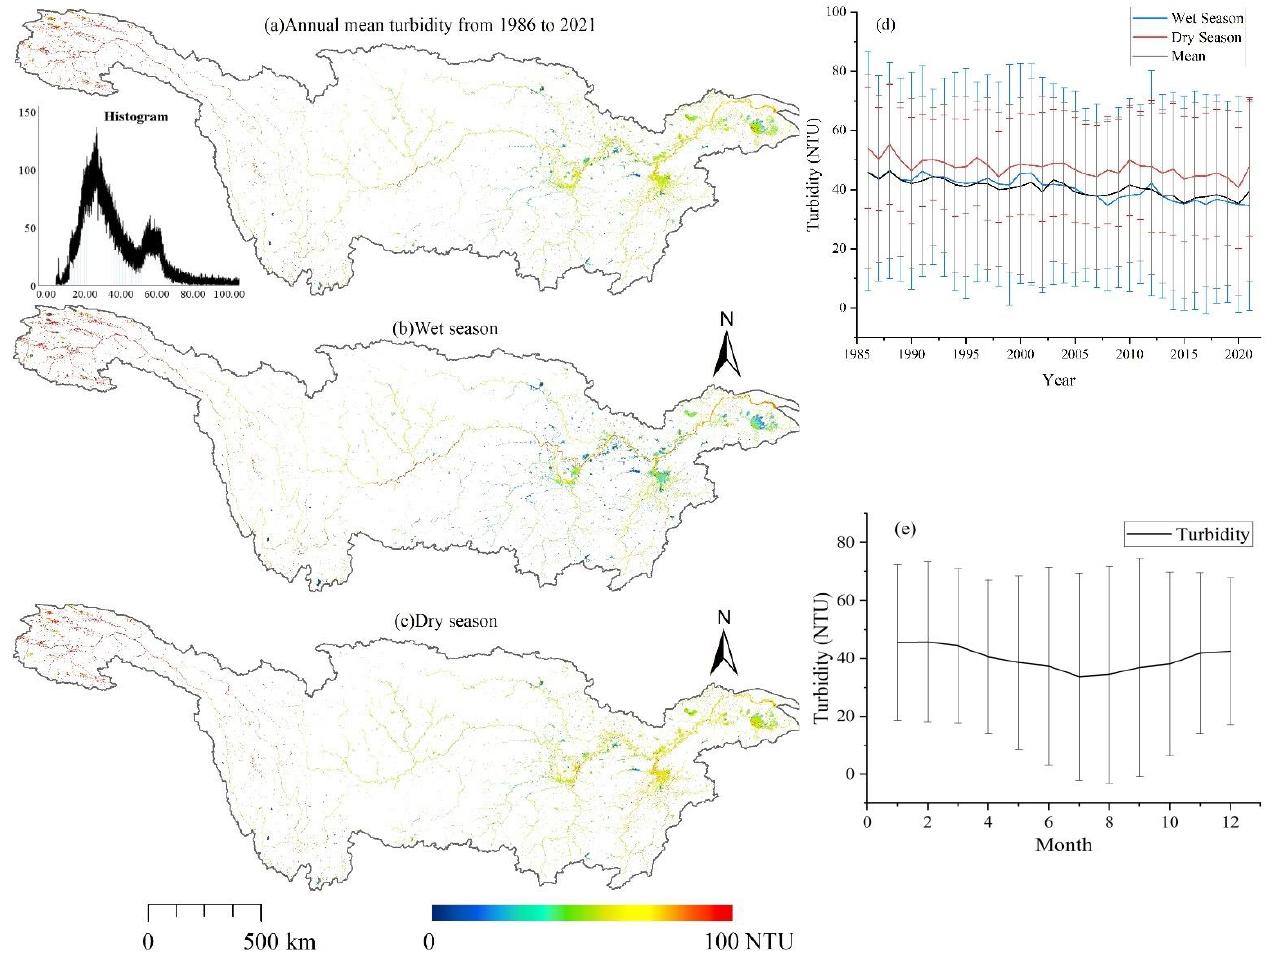
Figure 8. Spatial distribution of turbidity in the Yangtze River Basin from 1986 to 2021. ( a ) mean of 36 years and histogram of turbidity; ( b ) wet season; ( c ) dry season; ( d ) annual variations; ( e ) monthly variation.